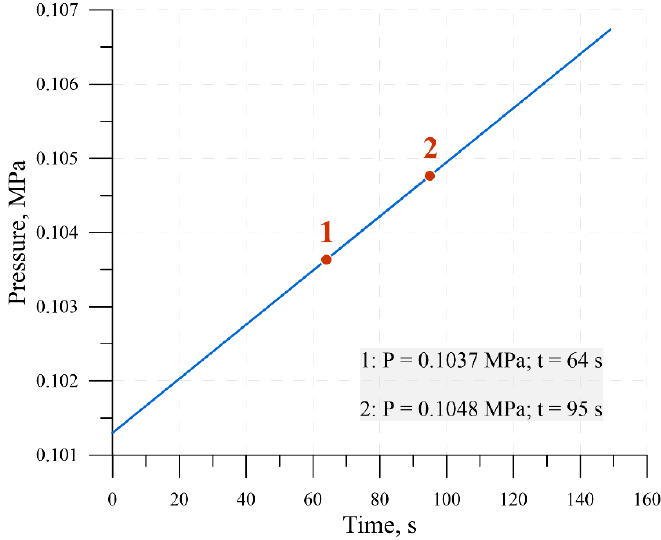
Figure 8. Time dependence of pressure at the cell bottom.